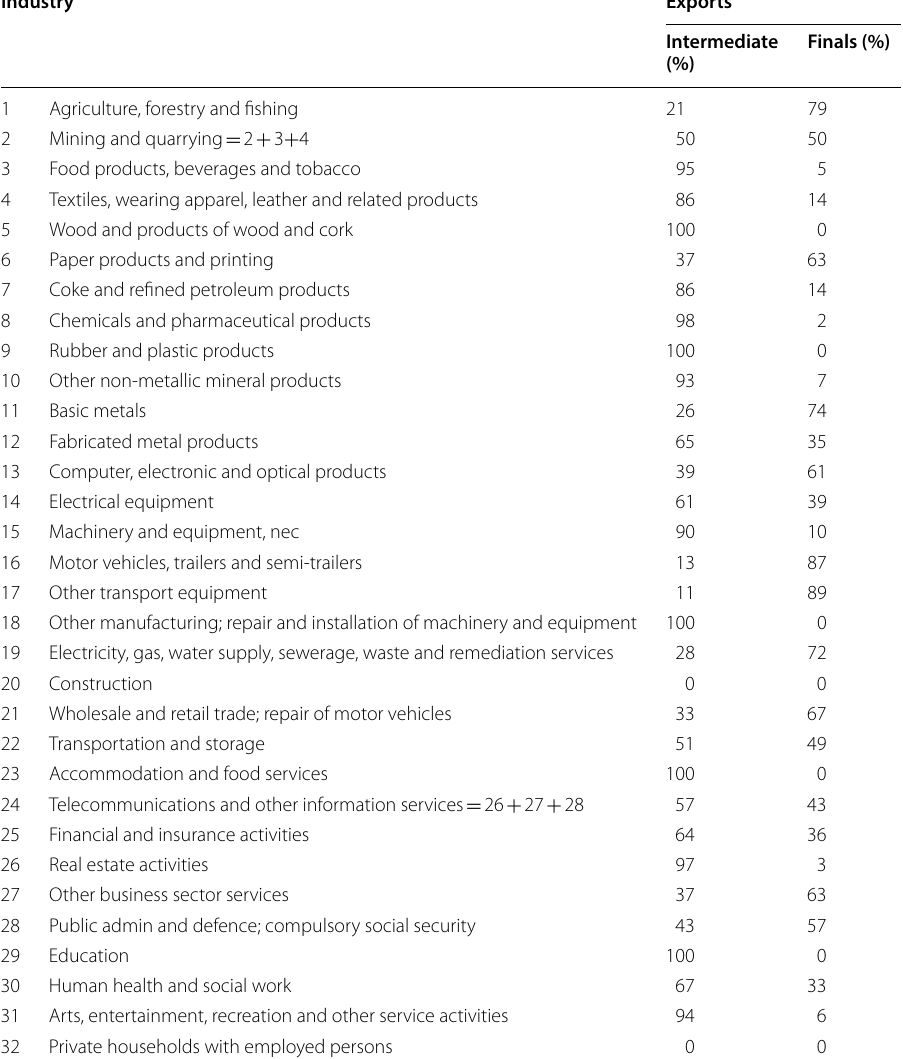
Table 4 Shares of intermediate and final exports and imports. Source: authors calculations based on DANE (2009) and ICIO (OCDE